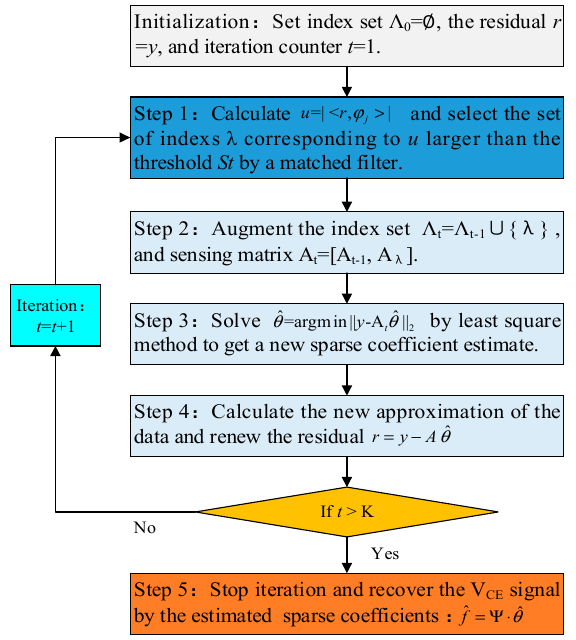
Figure 4. Flowchart of the StOMP algorithm for reconstruction of V CE signal .